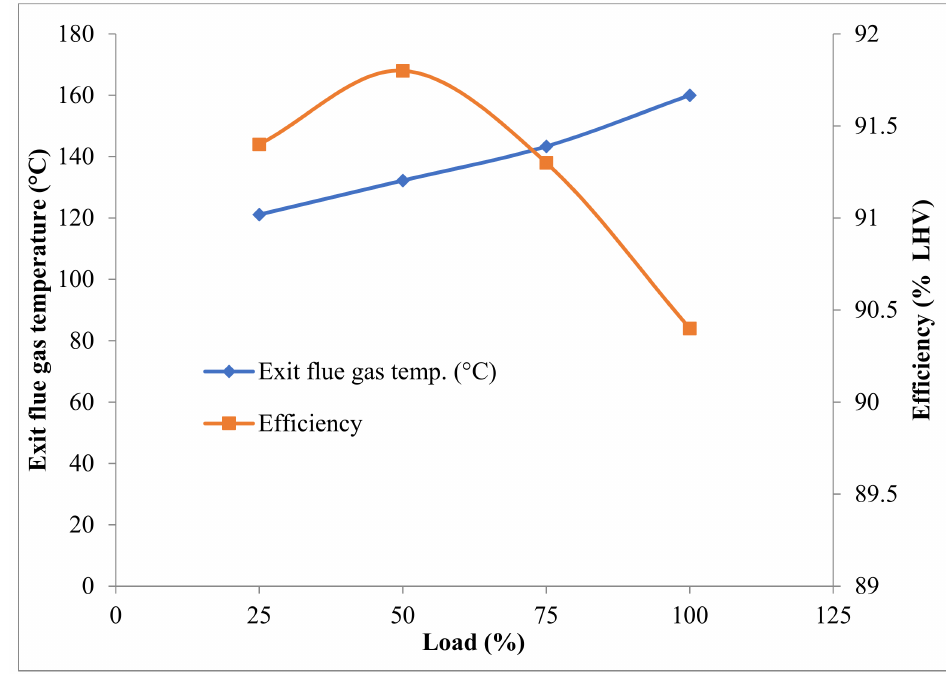
Figure 5. Performance curve of packaged boiler.